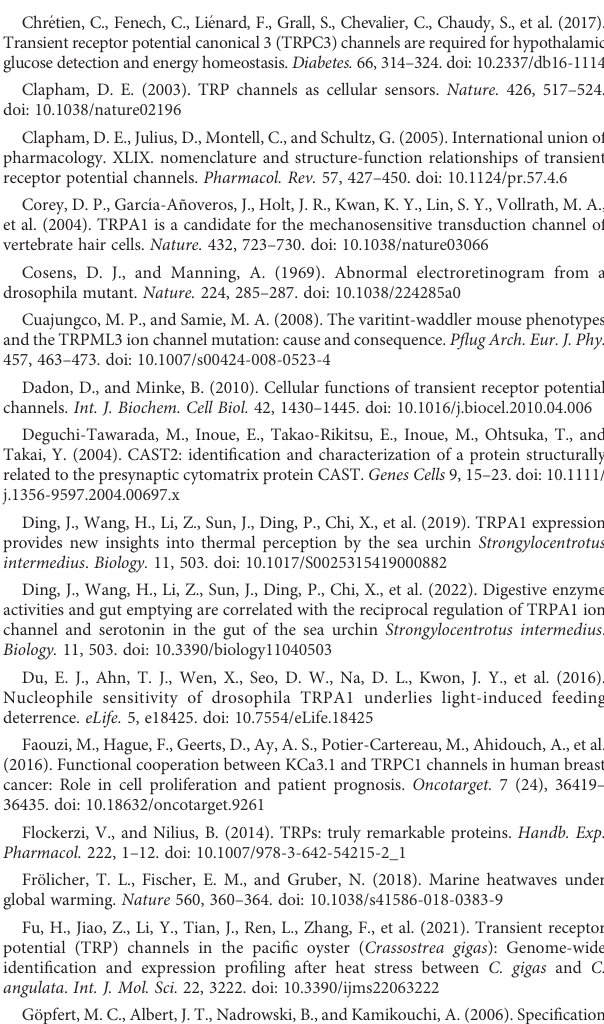
SUPPLEMENTARY FIGURE 5 Distribution of TRP genes across the chromosomes of A. japonicus . The scale on the left is in million bases (Mb). Chromosome numbers are shown at the top of each vertical bar. Genomic locations of TRP genes are marked with the black lines.